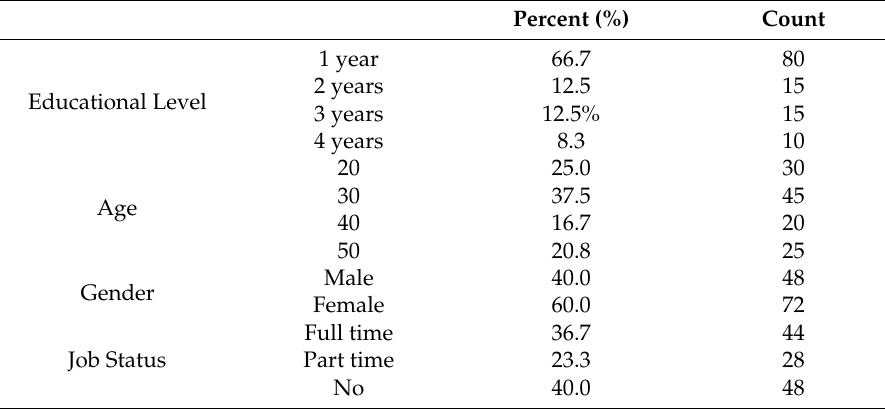
Table 1. Descriptive statistics of the